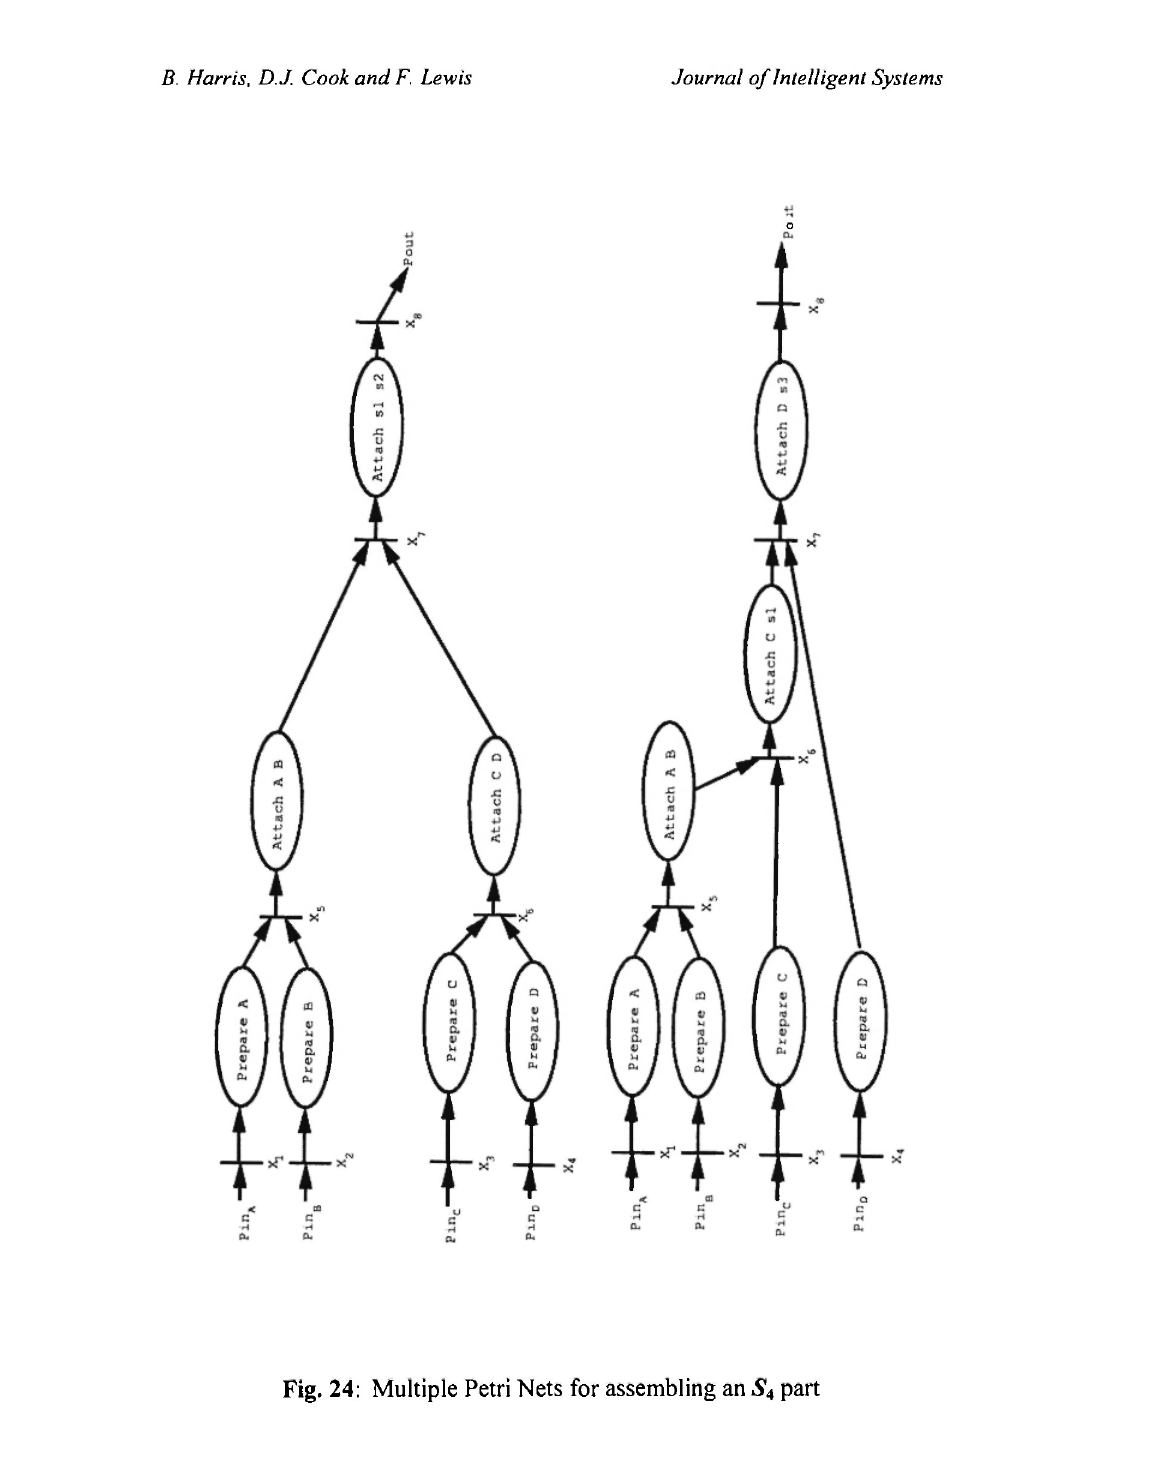
Fig. 24: Multiple Petri Nets for assembling an S 4